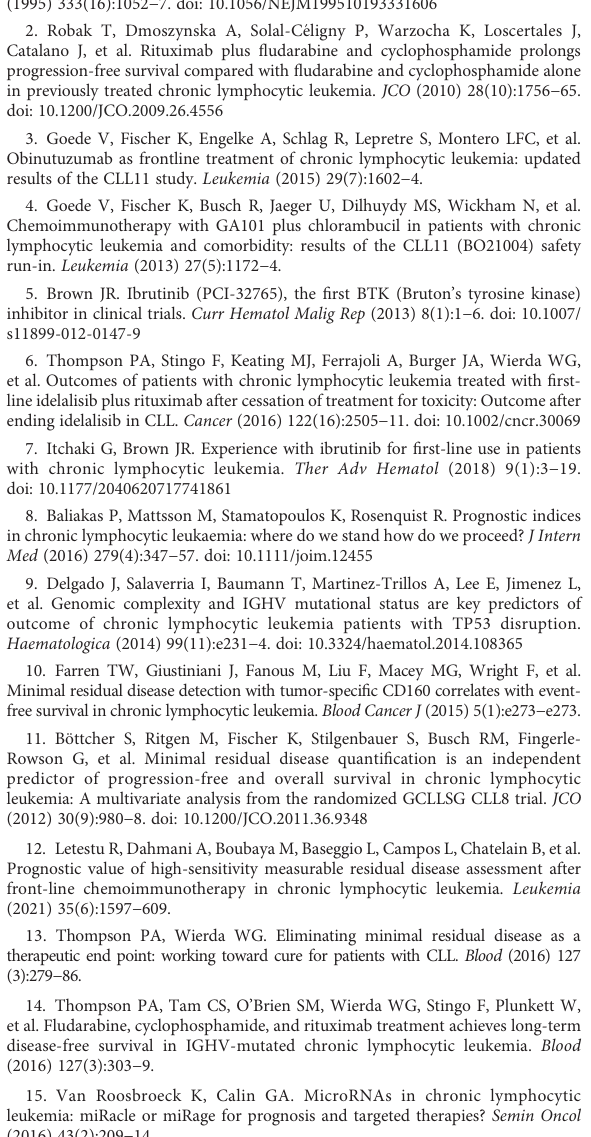
Bone Marrow.; OR, Odds ratio; CI, Con fi dence Interval; Ind, indeterminable. Patients with no-CR, with MRD-positive or with no-CR- uMRD in BM are used as the OR reference group. SUPPLEMENTARY TABLE 2 Association between blood lymphocytosis at diagnosis and the six miRNA-based prognostic signatures. Mediane values of blood lymphocyte counts (G/L) and CD20 expression (MESF: molecules